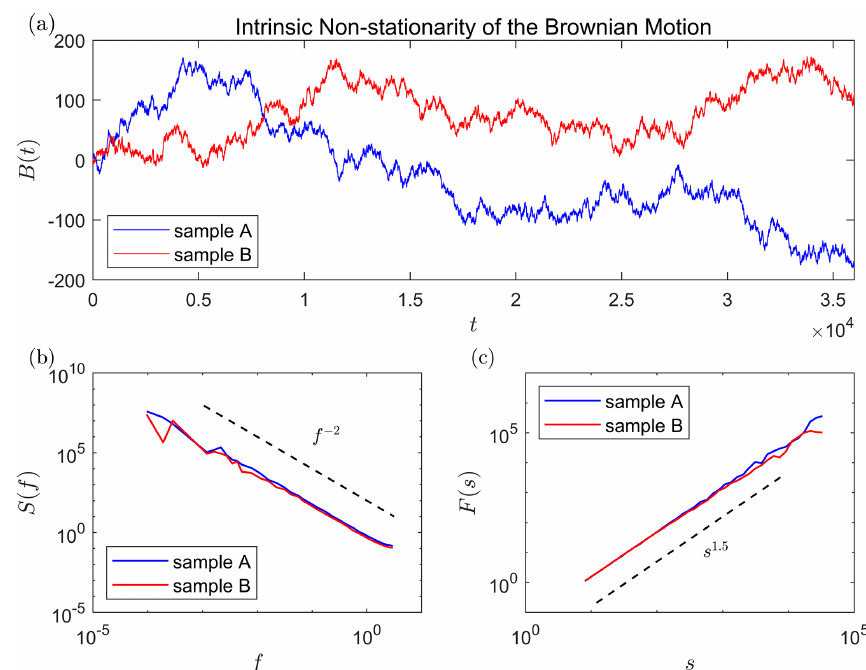
Figure 1. Illustration of intrinsic non-stationarity by the Brownian motion. (a) Two time series of the Brownian motion. The standard deviation of g i in Eq. (2) is set to 1. The time series length is 36000. (b) The spectra analysis of the two series, where the power spectral density S(f ) is plotted as a function of frequency f . (c) The detrended fluctuation analysis of the two series, where the fluctuation function F(s) is plotted as a function of timescale s . The theoretical predictions are shown by broken lines in panels (b) and (c)